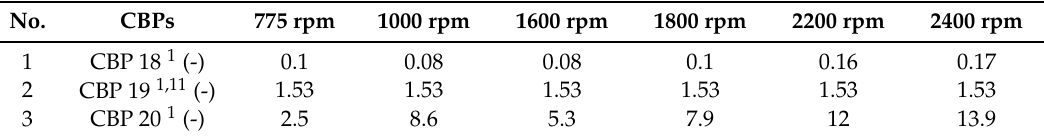
Table 5. Evaluated CBPs (Table 1) of the sub ‐ system SS 4 at part ‐ load operating points. No.